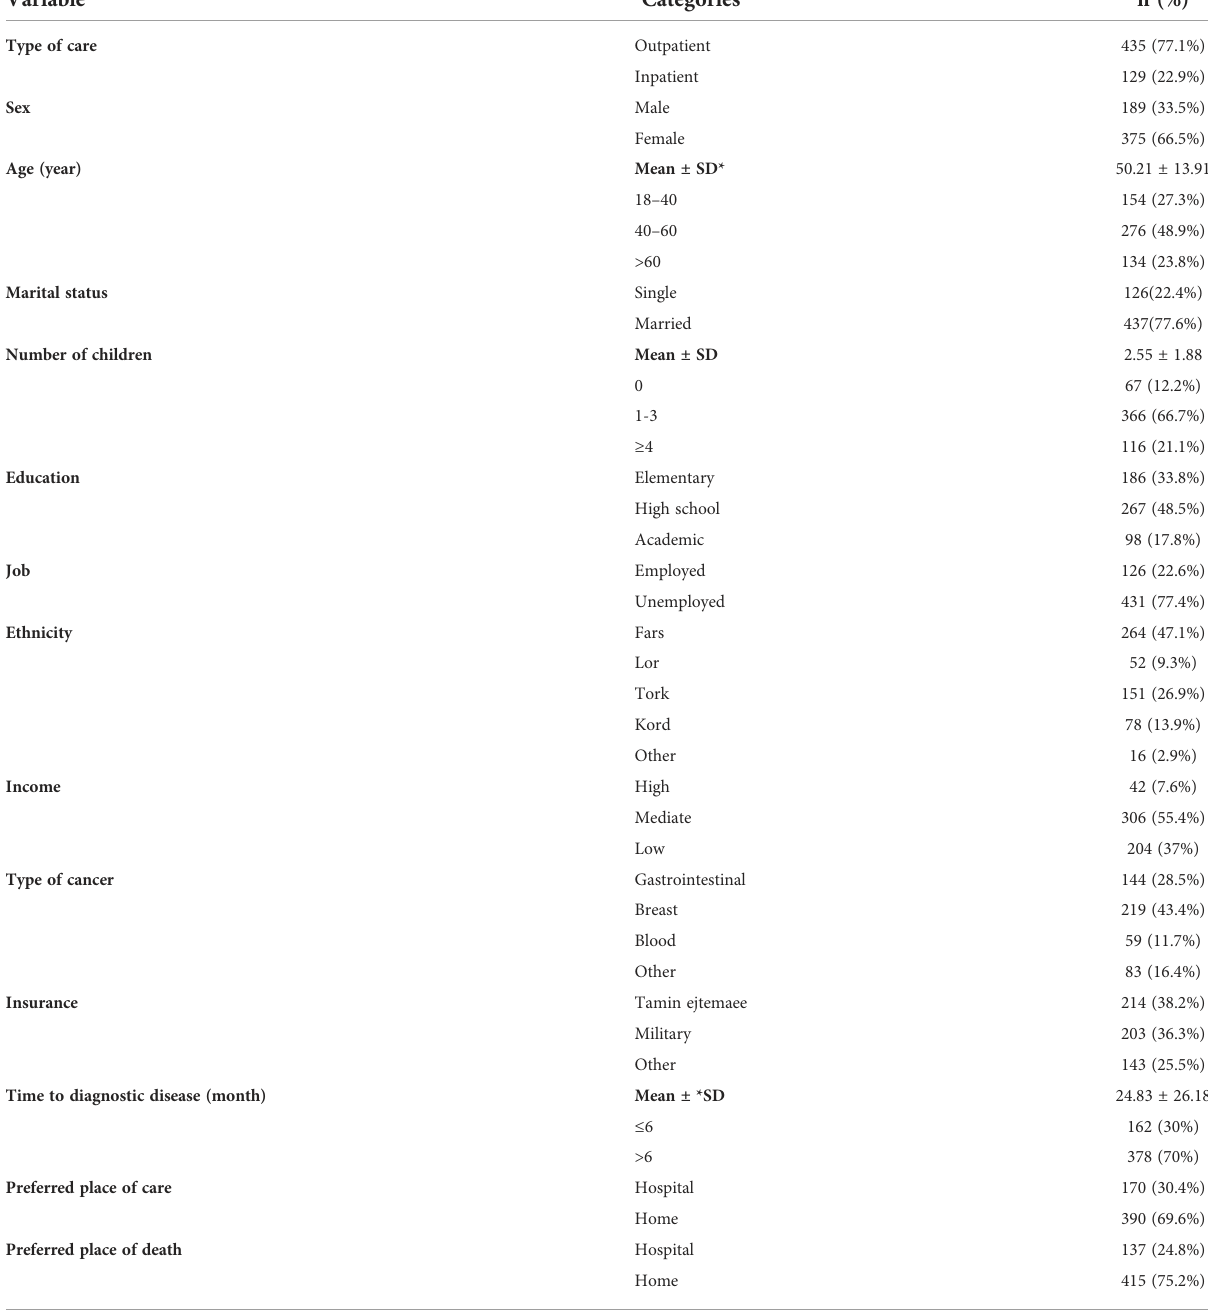
TABLE 1 Demographic and clinical characteristics of the 564 cancer